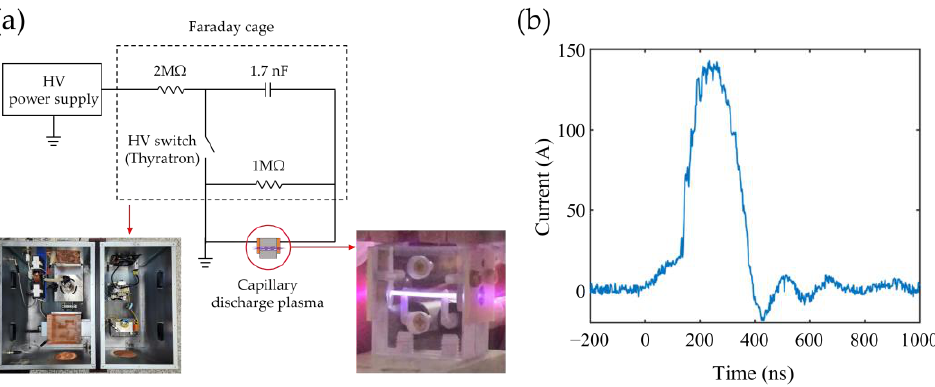
Figure 6. ( a ) Schematic diagram of the pulsed, high-voltage discharge system. The pulsed, HV dis- charge system and a 15 mm, helium-filled capillary discharge plasma are shown in the inner pho- tographs. ( b ) The current profile, with a peak current of 140 A, was obtained by applying the voltage of 10 kV.